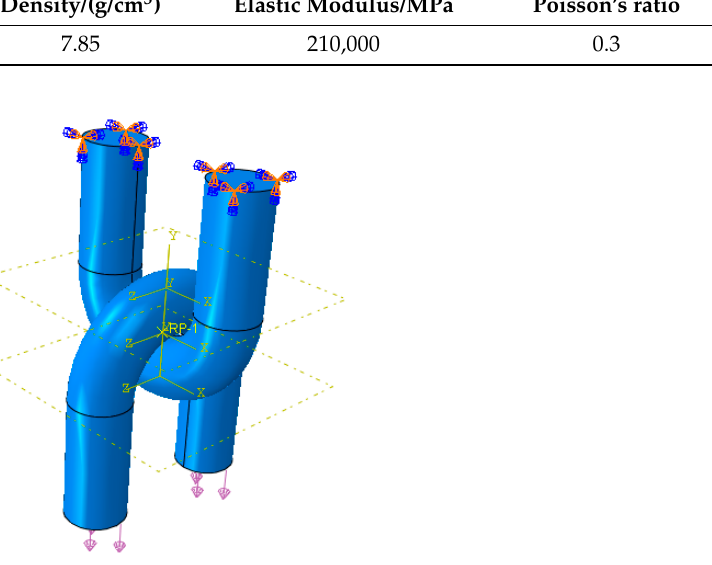
Figure 12. U-shaped ring imposed boundary conditions.